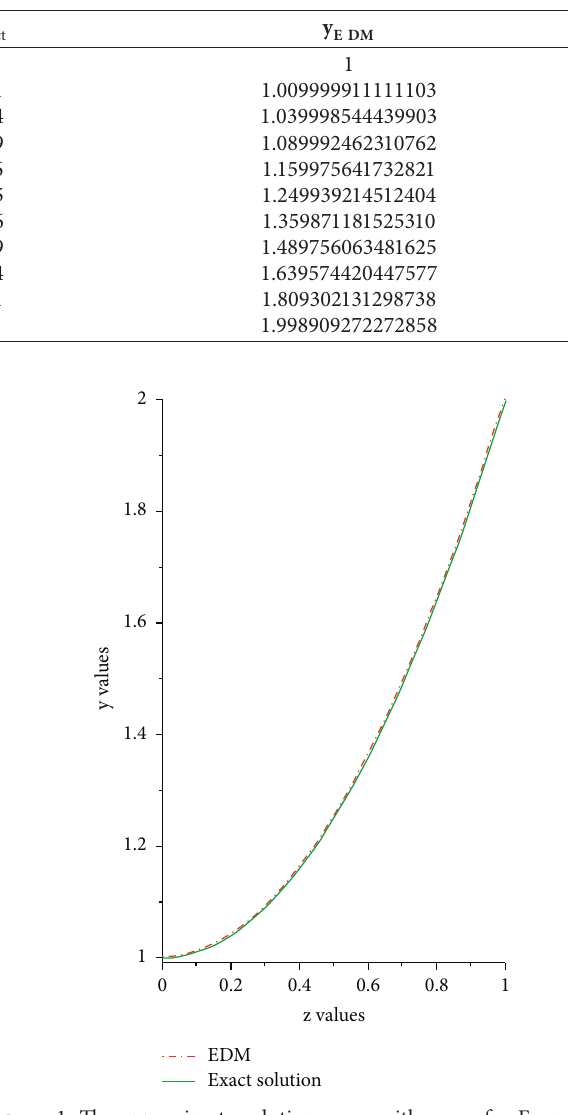
and y for Example 2. EDM exact